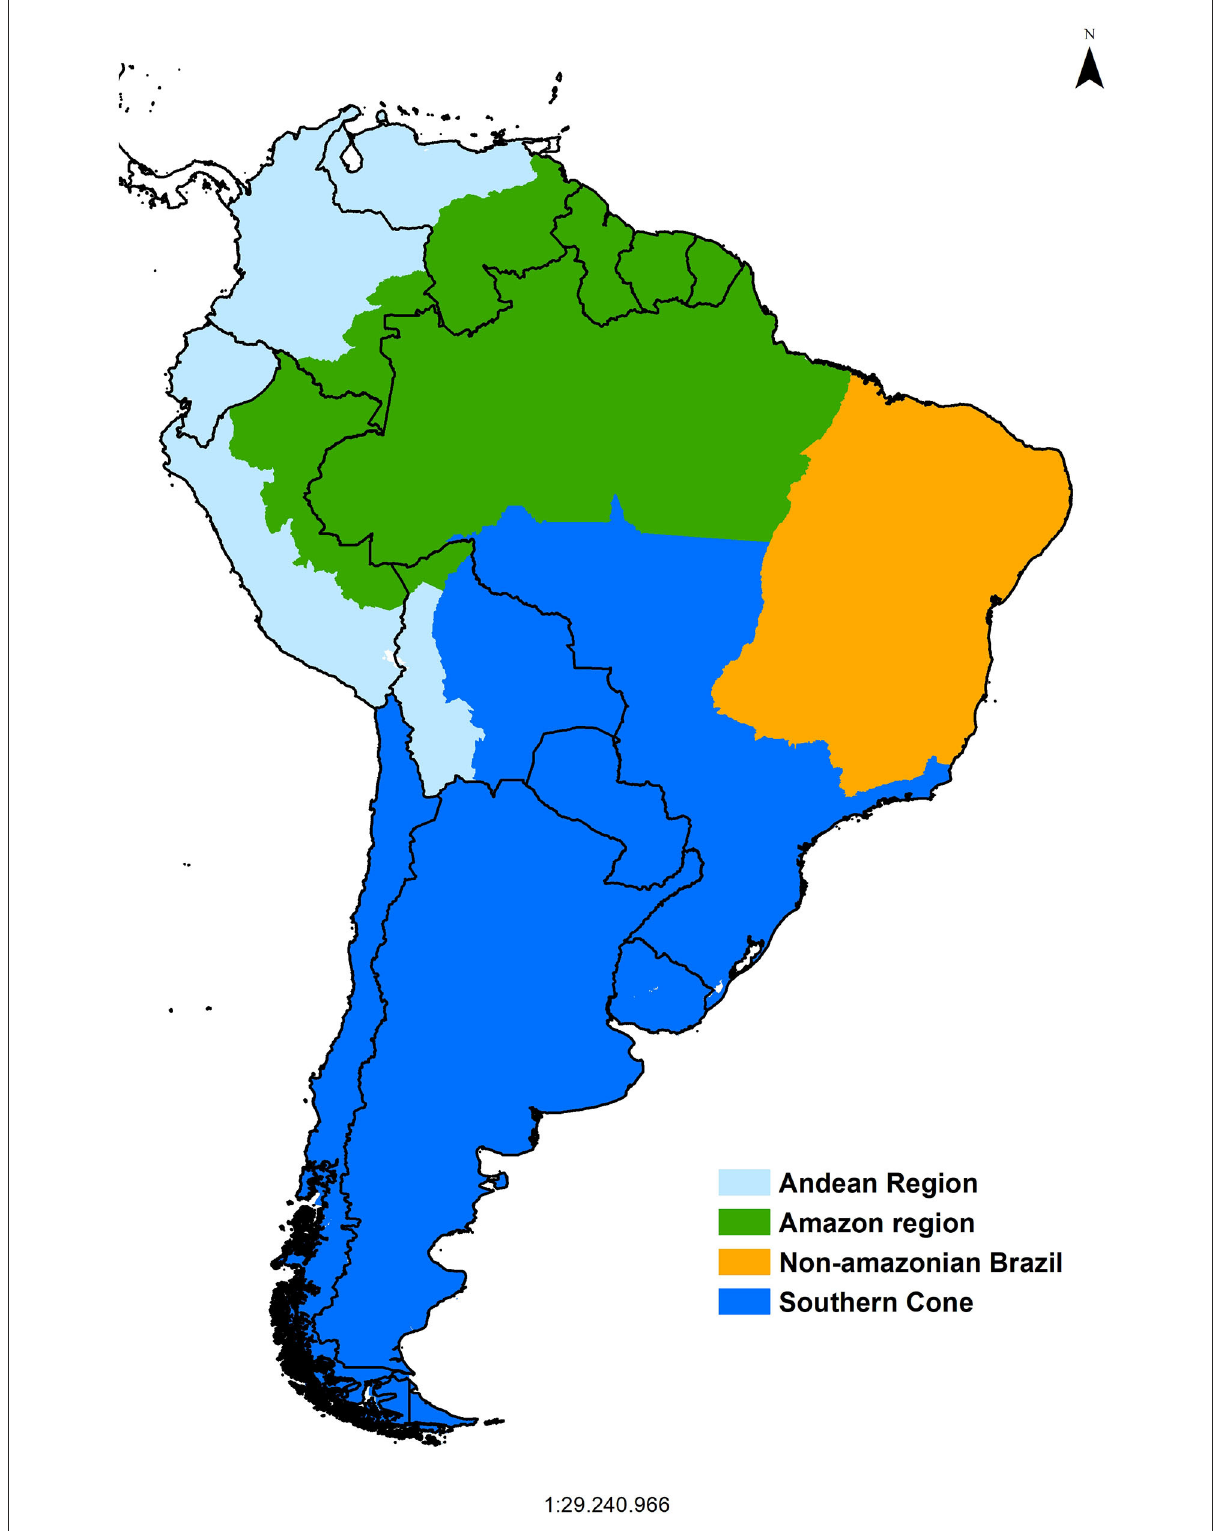
FIGURE1 PHEFA South American sub-regions.